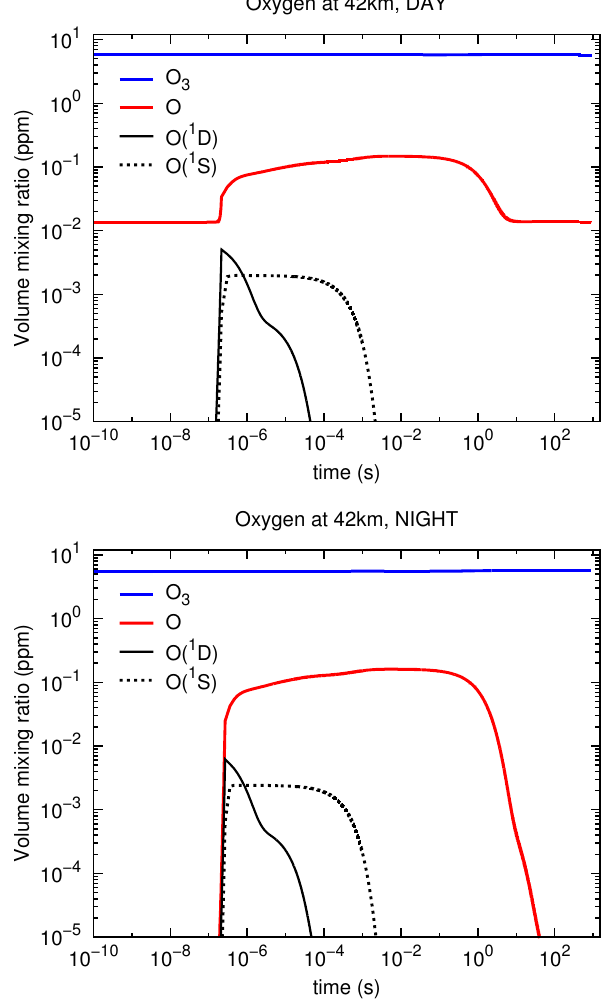
Fig. 4. Modelled evolution of the volume mixing ratios of oxygen species in a sprite streamer at 42 km altitude. Upper panel: daytime; lower panel: nighttime.